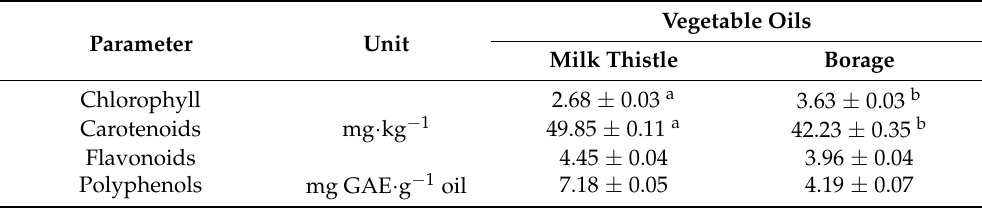
Table 4. Content of total chlorophylls and carotenoids in the oils.